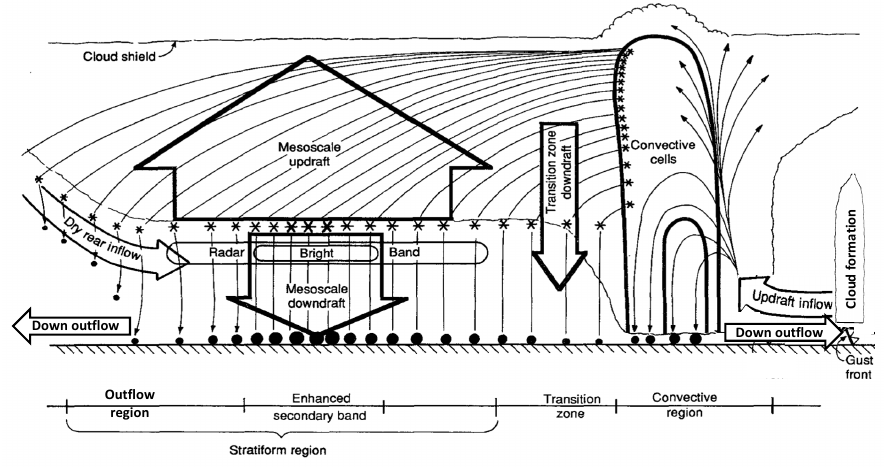
Figure 1. Conceptual model of a mesoscale convective system showing 2D hydrometeor trajectories through stratiform region of a squall line with trailing stratiform precipitation. (Modified from original ([5]) to show surface winds). Reprinted with permission from Ref. [5]. Copyright 1991 American Meteorological